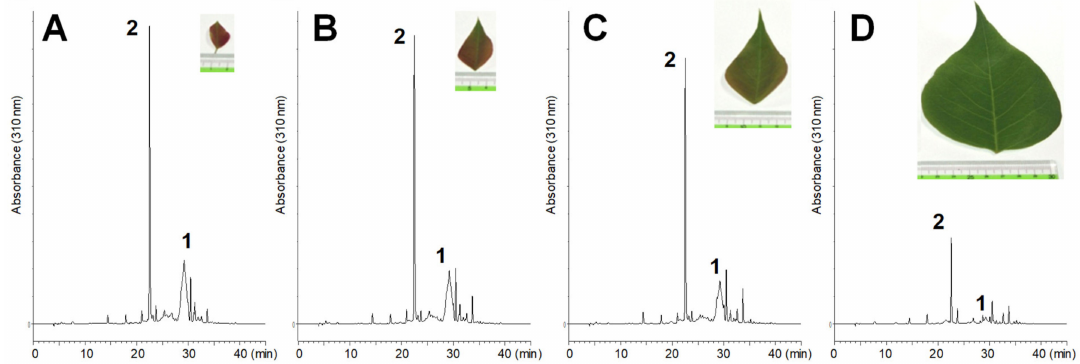
Figure 1. HPLC profiles (310 nm) of extracts of the leaves of Triadica sebifera .